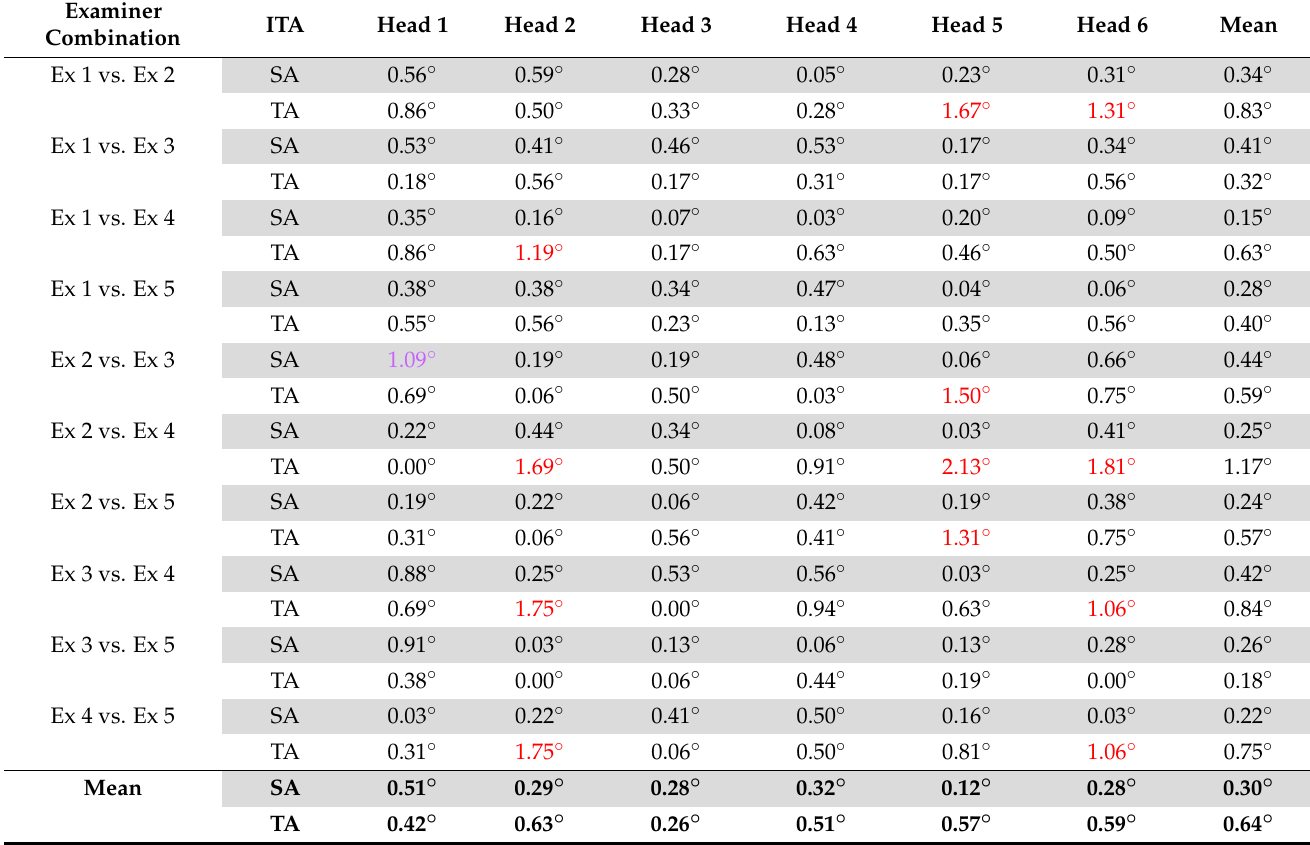
Table 3. Mean SA and TA difference ( α ◦ ) between examiners for different